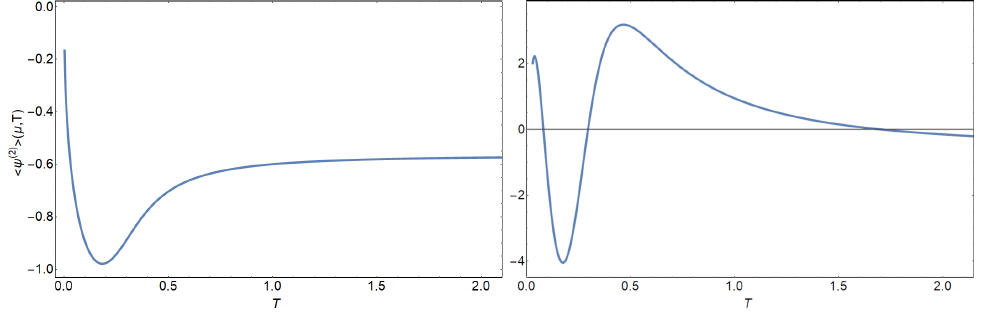
Figure 2 . Ψ 0 (0) = Ψ (2) ( µ, T ) as functions of T from numerically solving eq. (2.1) for µ = 0 . 3 (left) and 8 (right) for k = 1 , L = 1